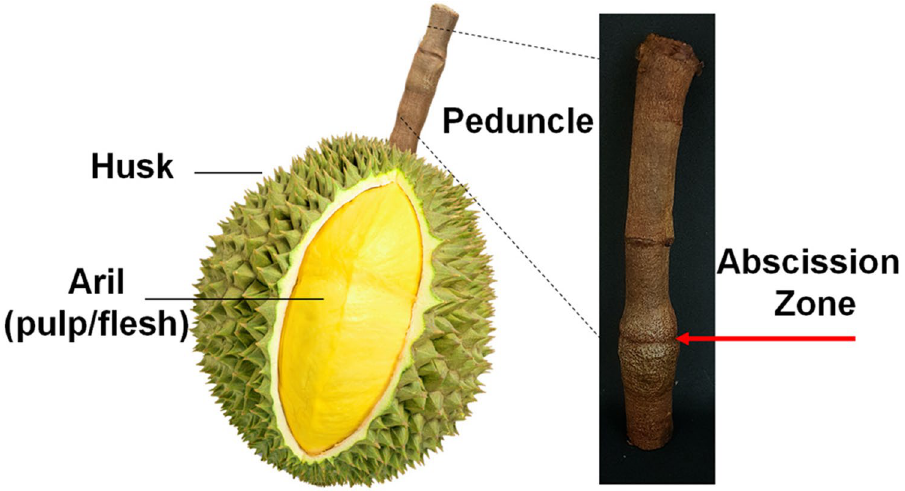
Figure 1. Illustrations of parts of durian fruit and the peduncle of durian